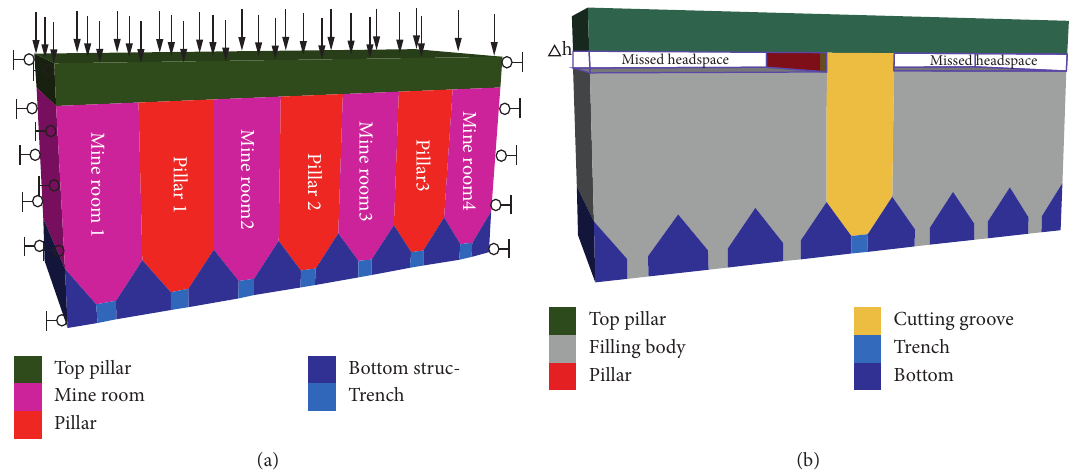
Figure 1: Numerical simulation model diagram. (a) Schematic diagram of boundary conditions. (b) Schematic diagram of stope model before cutting groove excavation